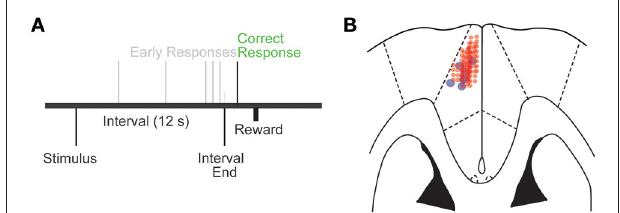
FIGURE 1 | (A) Interval timing task. Subjects estimate a 12s interval starting with the onset of a discriminative stimulus by making a motor response; multiple responses per trial are permitted. (B) Cannula locations in the MFC were reconstructed from histological sections; cannulae are marked by blue circles, and electrode locations by red